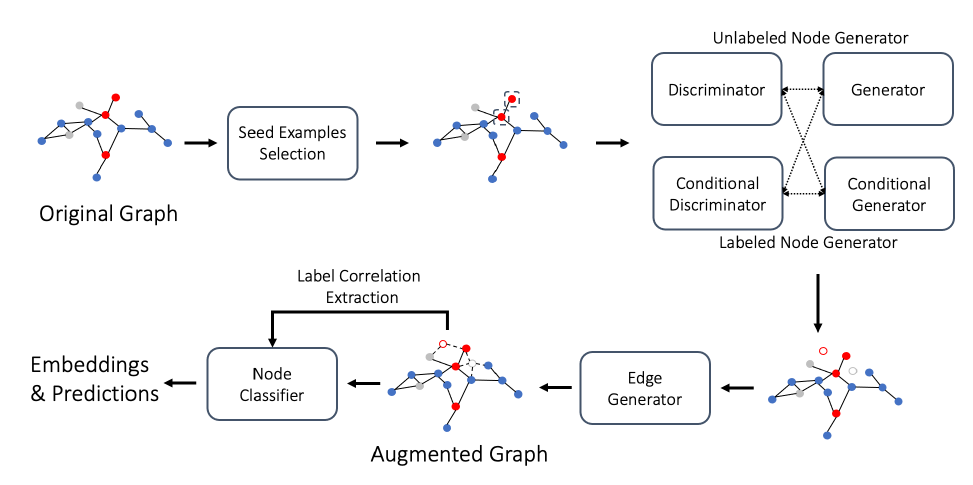
Figure 3. Overview of the SORAG framework. First, based on the feature matrix and the adjacency matrix of the input graph, we calculate the local minority degree (LMD) value of each node in the training set and classify it into one of the four types: safe (SF), borderline (BD), rare (RR), and outlier (OT). After that, we calculate the seed probability (SP) values of nodes in the SF and BD classes and select the seed nodes based on such values (see Section 3.2). Then, we use the seed nodes to train the node generator (i.e., the ensemble of GAN and CGAN) to generate high-quality unlabeled synthetic nodes and labeled synthetic nodes. Notice that by adjusting the objective function, we can flexibly manipulate the data distribution simulated by the node generator (see Section 3.3). With virtual nodes, an edge generator, which is essentially a feed-forward neural network, is used to generate virtual edges connecting the virtual nodes and the real nodes. The role of the generated edges is to facilitate feature propagation between two types of nodes (see Section 3.4). Finally, the new graph containing virtual nodes and virtual edges is fed into a GCN that learns the discriminative graph embeddings and performs effective node classification. During this process, the label correlation matrix provides helpful label correlation and interaction information (see Section